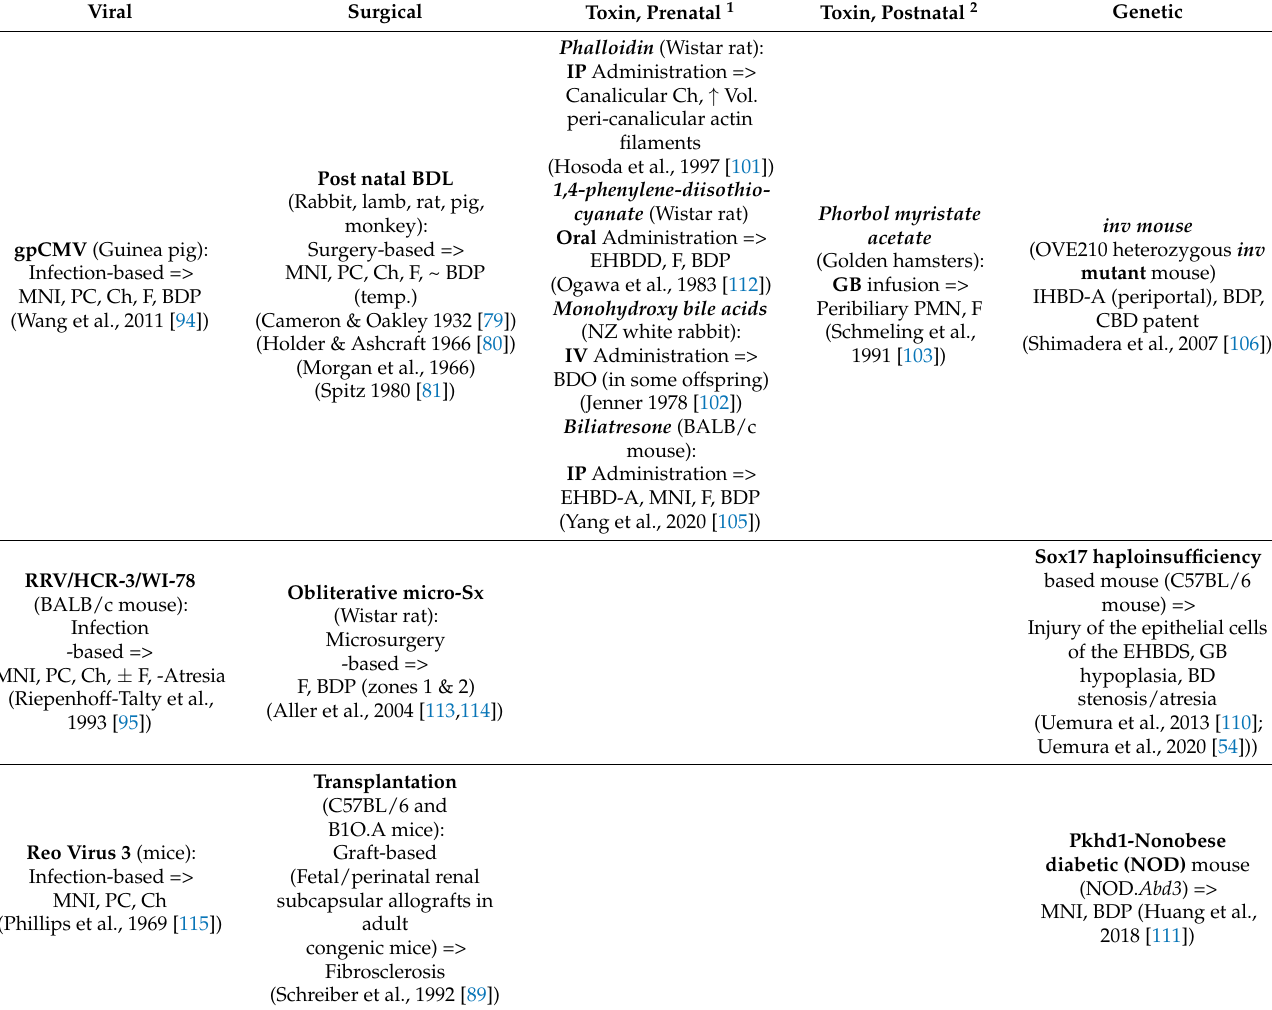
Table 1. Animal Models of Biliary